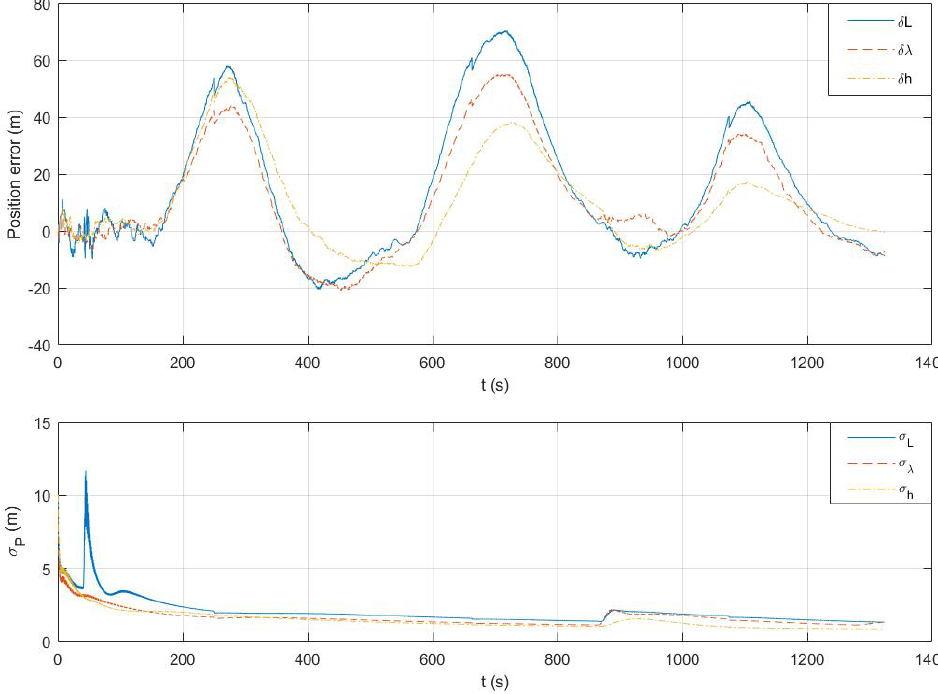
Figure 11. SINS/SAR/GPS position error and standard deviation without sensor credibility